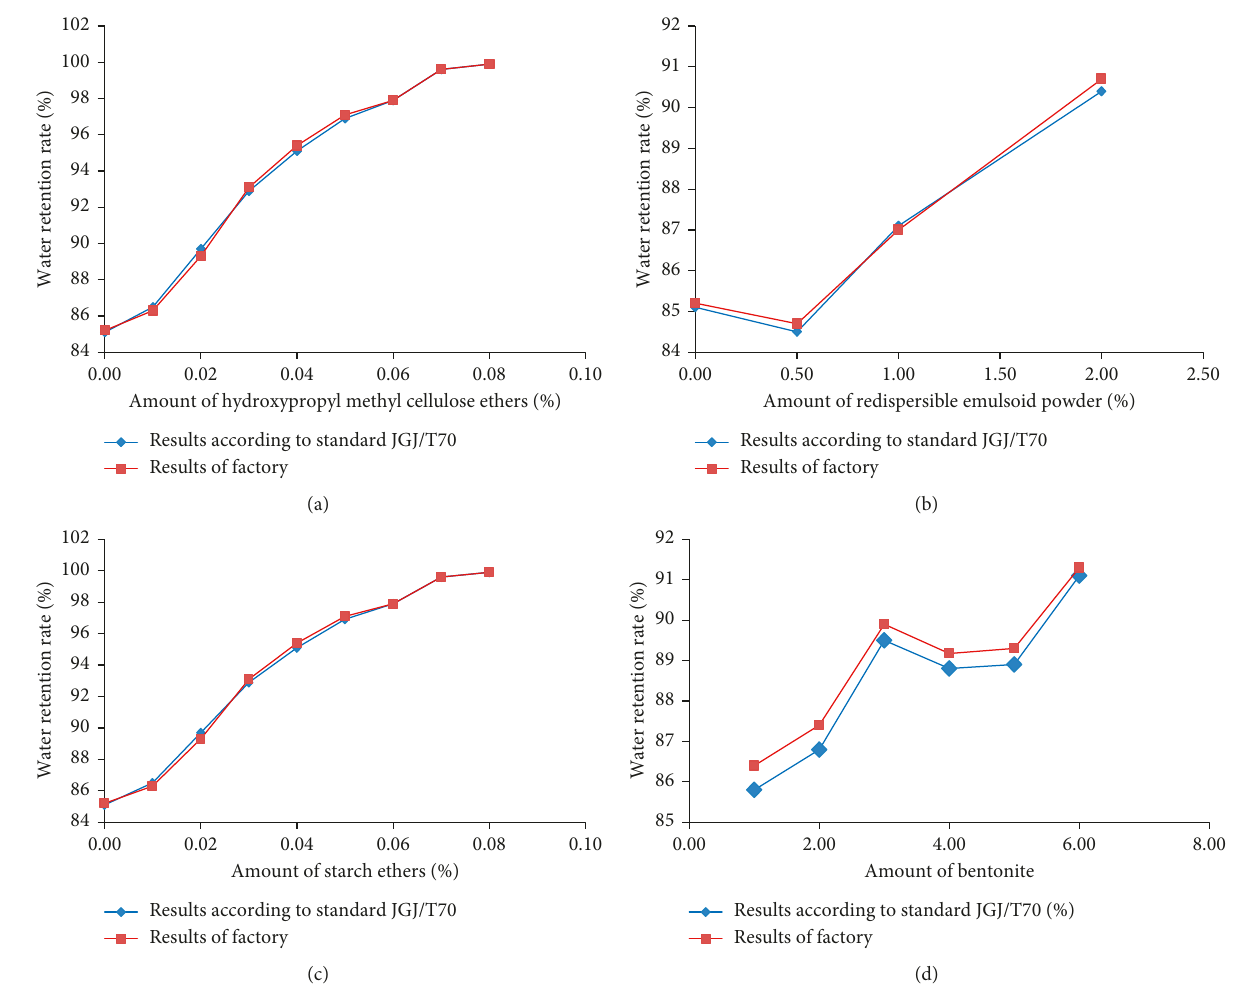
Figure 6: Influence of admixture on the mortar water-retention rate. (a) Hydroxypropyl methyl cellulose ethers. (b) Redispersion emulsoid powder. (c) Starch ethers. (d) Bentonite.